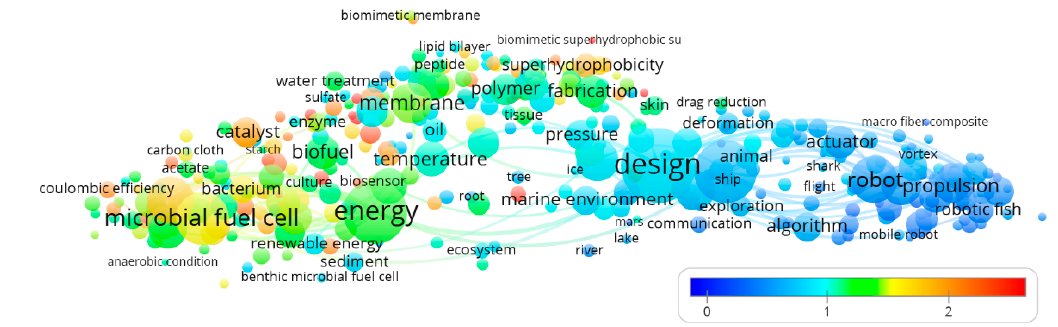
Figure 6. Term-citation map (average normalized citation) based on biomimicking publications. The scale represented the earlier (blue) or more recent (red) years when the term appeared. Terms are represented by a circle (node whose diameter and label size represent the number of publications where the term appears. Top 100 linkages were represented.